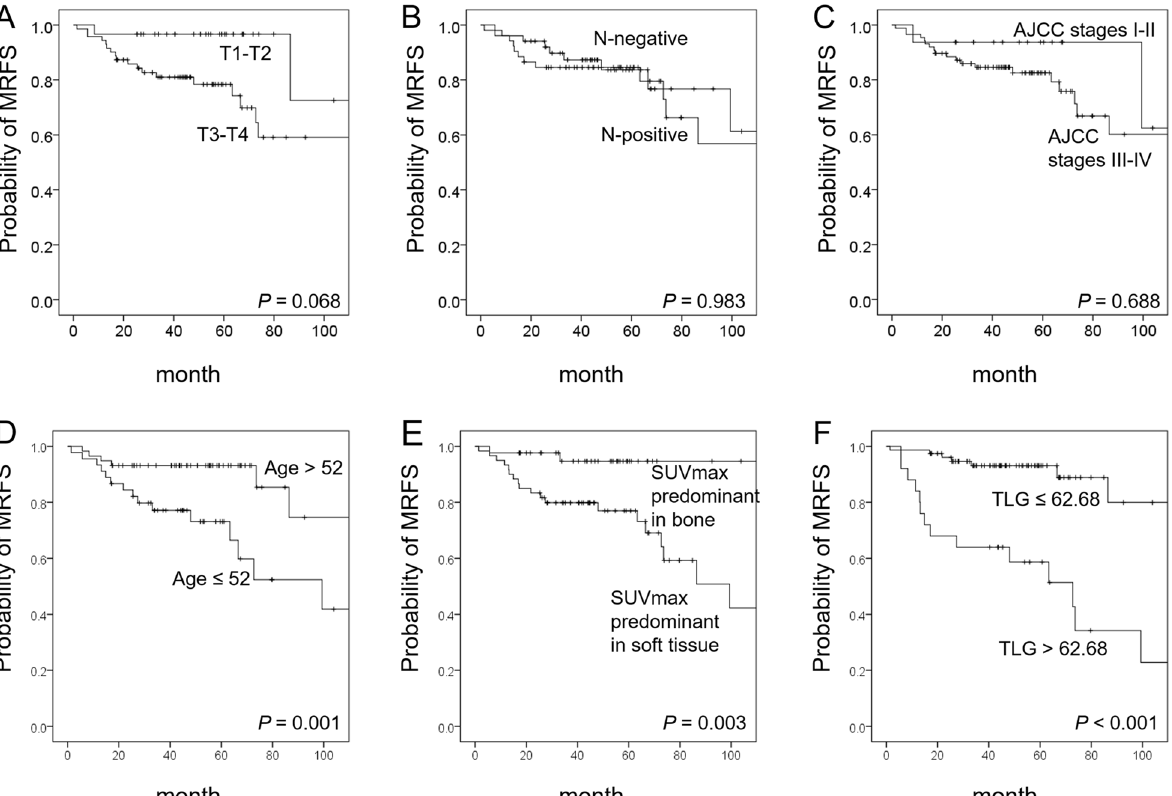
Fig. 1 Kaplan–Meier plots of mandibular relapse‑free survival (MRFS) rates in patients with OSCC stratified according to T stage ( A ), N stage ( B ), AJCC stage ( C ), age at cancer diagnosis ( D ), SUVmax site ( E ), and TLG ( F ). The Youden’s statistic was used to determine the optimal cut‑off point for each variable. P values according to log‑rank tests are presented in the